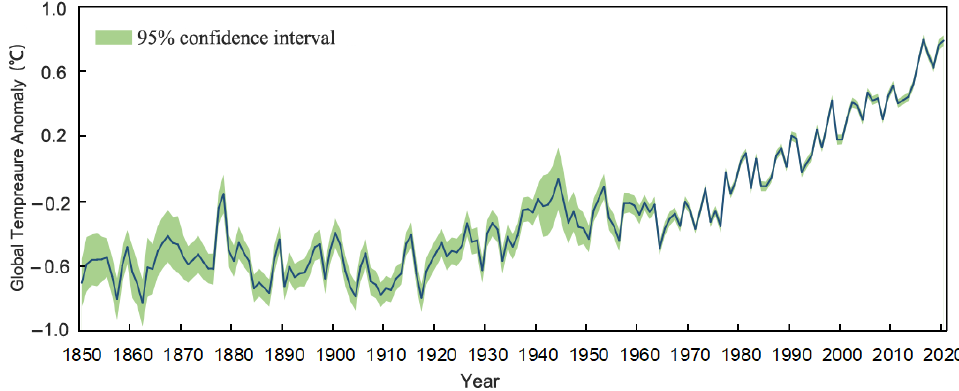
Figure 5. Global average surface temperature anomaly from 1850 to 2020 (relative to the average value from 1970 to 2000).